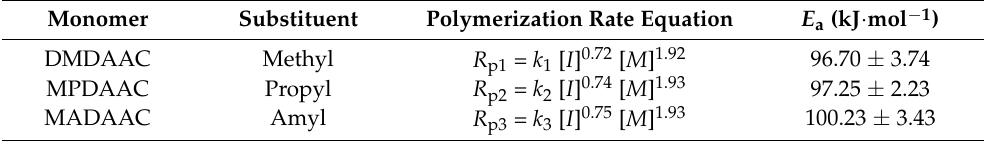
Table 6. Polymerization rate equation and the activation energy of polymerization of monomer.